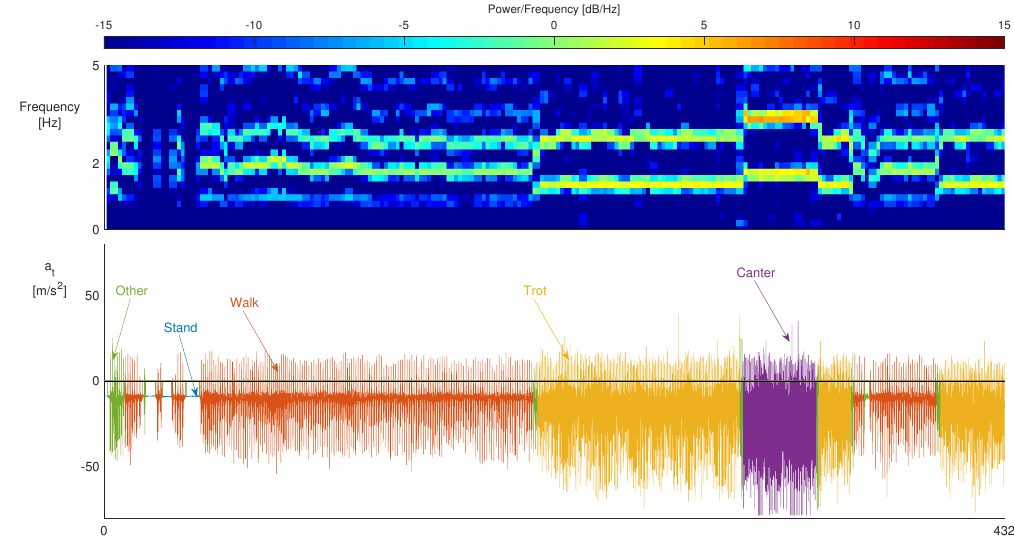
Figure 4. The different dominant frequencies in the x-axis for multiple gaits (top the spectrogram) is shown for frequencies between 0 and 5 Hz. The bottom graph shows the accelerometer data on the same time scale. In the dataset, the different gaits alternate each other and the transition between the different gaits is labeled as ‘other’. In the gaits themselves, small variations between most energetic frequencies and energy levels can be